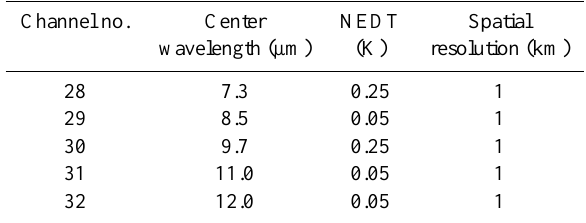
Table 2. Training, test and validation sets for the ash mass, r eff and AOD